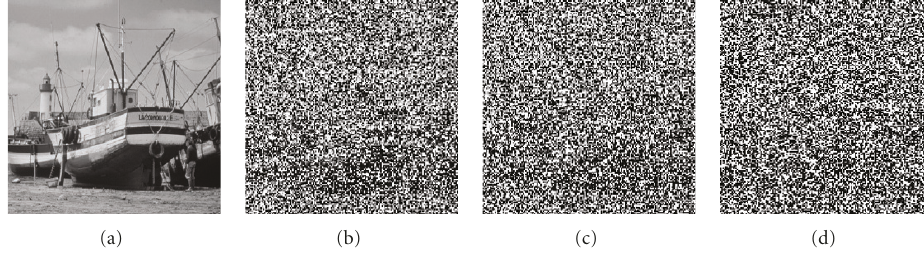
Figure 4: (a) Original Boat image. (b) Image corrupted by 70% noise density. (c) Image corrupted by 80% noise density. (d) Image corrupted by 90% noise